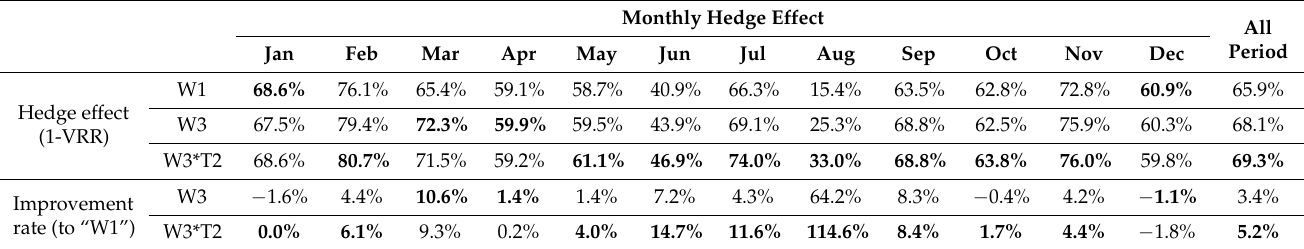
Figure 6. Realized versus predicted values of wind power generation in the out-of-sample period (Upper: 2020, Lower: February 2020). Note: the upper graph plots daily averaged values for visibility. The realized data are the raw wind production data downloaded from https://www.nordpoolgroup. com/en/Market-data1/ (accessed on 11 January 2021). Table 2. Monthly hedge effect and improvement rate against the W1